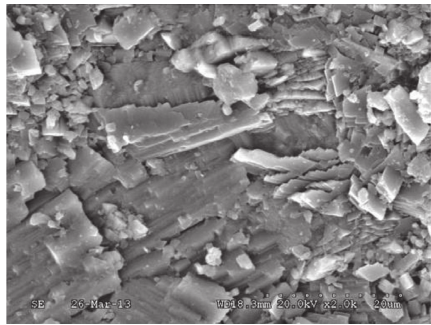
Figure 25: Microscopic image of impact failure of the rock mass in the slip zone of the Daguangbao landslide